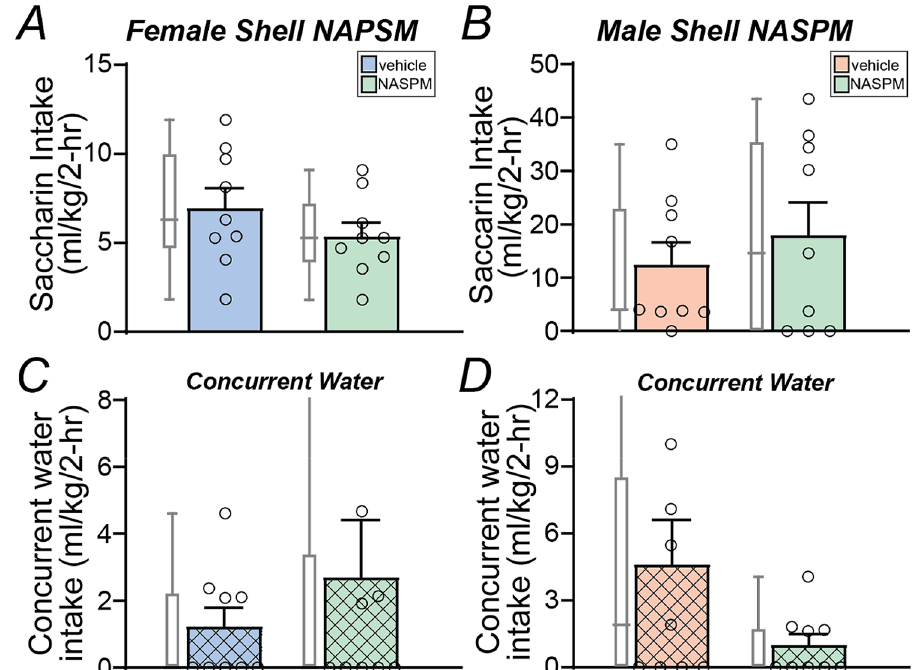
Figure 4. Shell CP-AMPAR inhibition did not reduce saccharin intake in either sex. ( A , B ) Intra-shell infusion of NASPM did not reduce saccharin intake in either sex. ( C , D ) Intra-shell NASPM did not reduce concurrent water intake in either sex, although a trend is seen in males. One vehicle data point in ( C ) was 15.7 ml/kg, and one NASPM in ( D ) was 17.1 ml/kg, not shown on graphs. Saccharin intake was not different across sexes ( p > 0.9